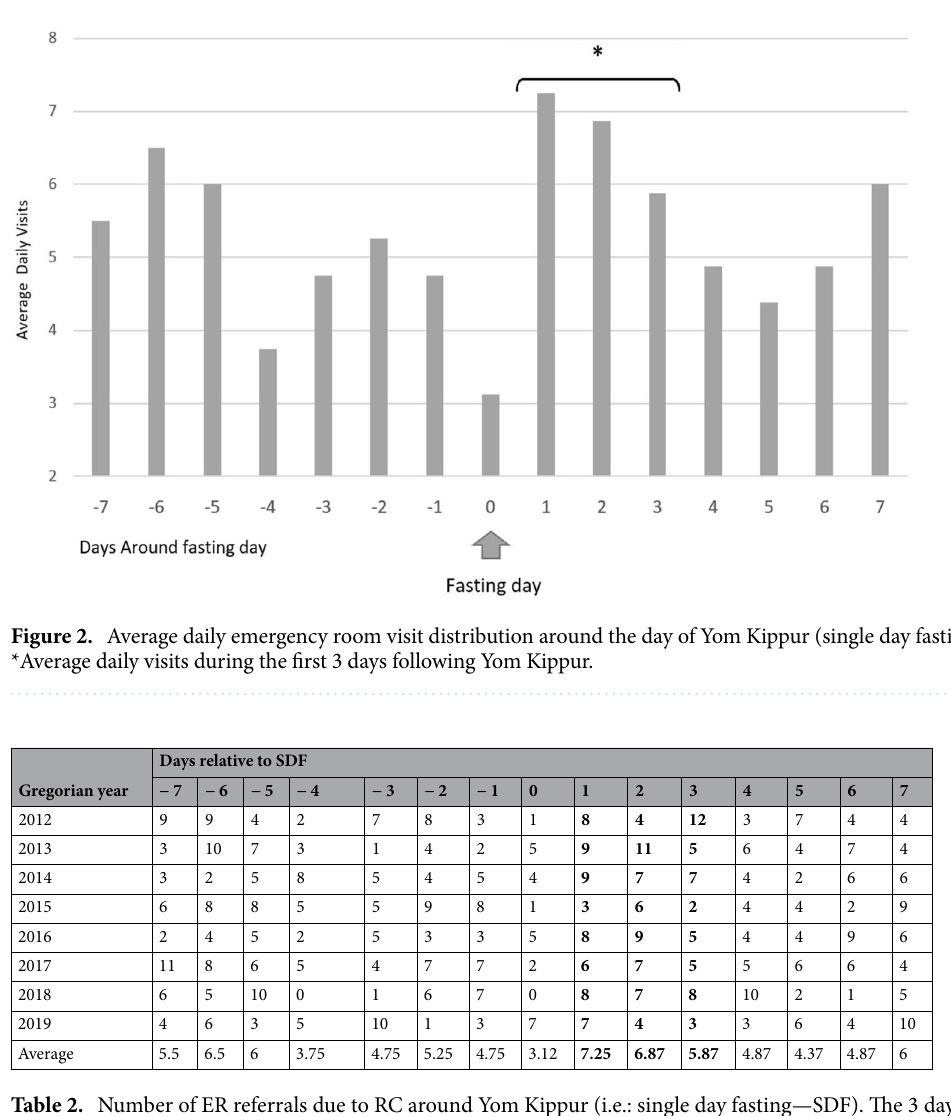
Table 2. Number of ER referrals due to RC around Yom Kippur (i.e.: single day fasting—SDF). The 3 days following SDF are